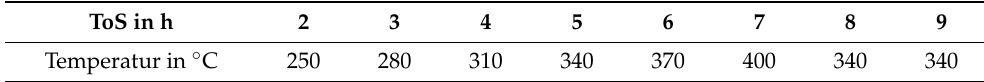
Table 4. Temperature profile for catalytic tests in the conversion of guaiacol. The temperature was increased at the beginning of each hour time on stream (ToS) at 3 K/min. The test were conducted at 15 bar (gauge), 10 L/h hydrogen flow, 3 mL/h (liquid) guaiacol, and 0.5 g catalyst. ToS in h 2 3 4 5 6 7 8 9 Temperatur in ◦ C 250 280 310 340 370 400 340 340 The gaseous products are analyzed online by gas chromatography (Clarus 590 from